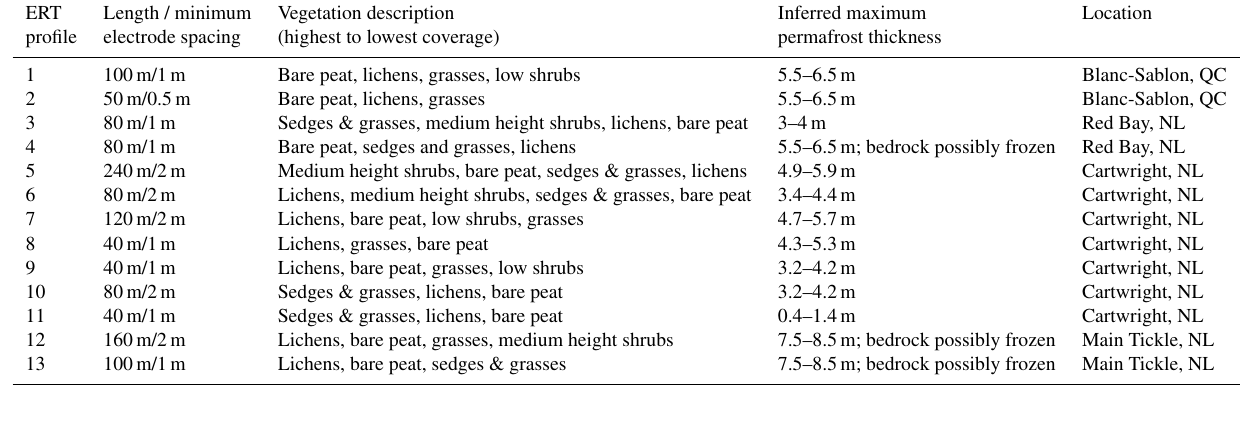
Table 3. ERT surveys and inferred permafrost thickness.